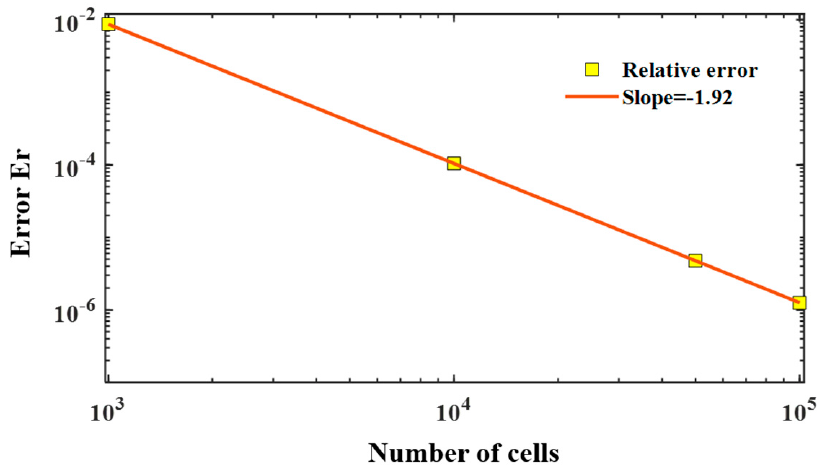
Figure 5. Numerical error as a function of LBM grid cell number.